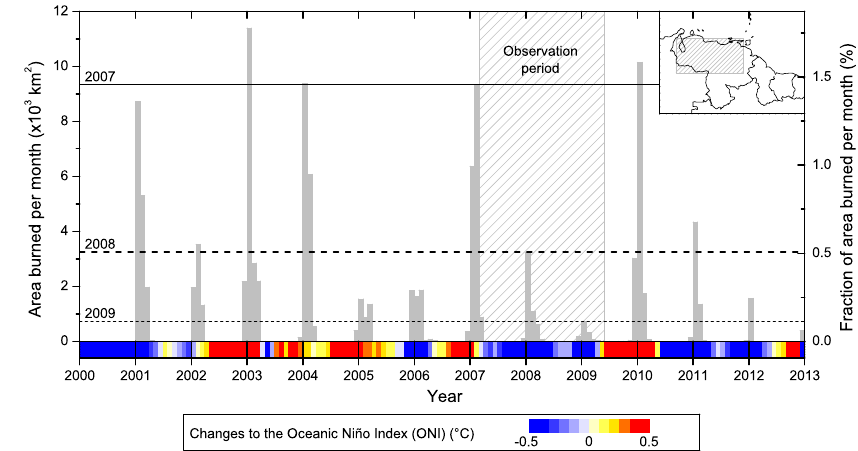
Fig. 8. Time series of the area affected by fires for the wider region of Venezuela (km 2 ) (see Sect. 2.4 for details). The data is based on MODIS satellite observations. The horizontal lines indicate the maxima for the dry seasons during the observation period at the Pico Espejo. The colour coded x axes shows periods with El Ninõ conditions (red) and La Niña conditions (blue).